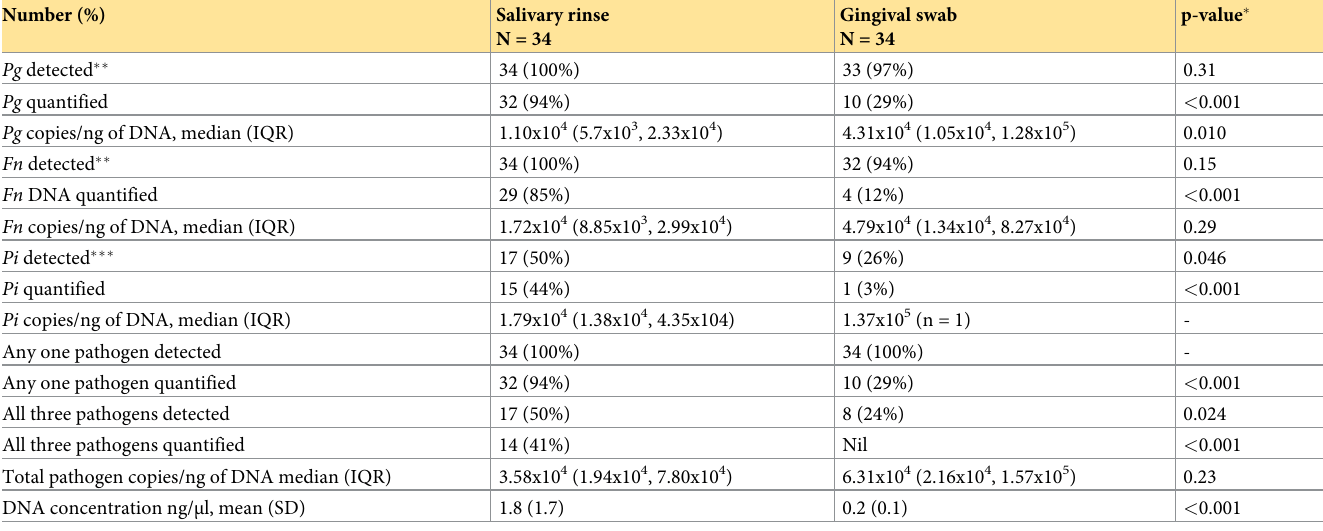
Table 3. Comparison of distribution of P . gingivalis (Pg) , F . nucleatum (Fn) , P . intermedia (Pi) in salivary rinse versus gingival swab samples (N = 34 participants; 9 cases and 25